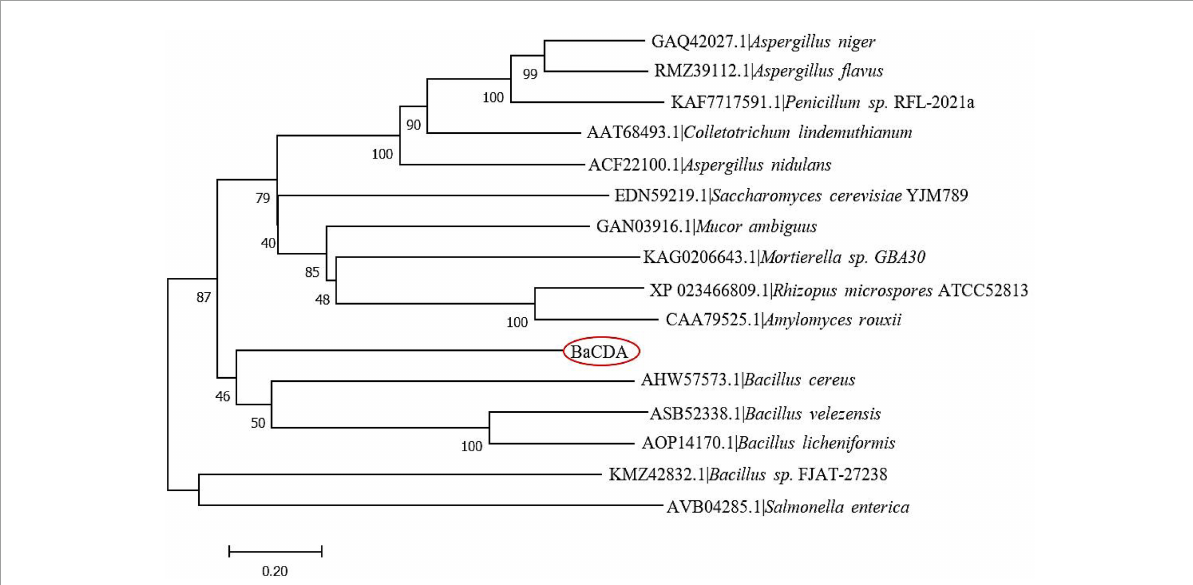
FIGURE9 Phylogenetic tree of B. aryabhattai TCI-16 CDA (BaCDA) with other CDA proteins from different microorganisms based on the amino acid sequence comparisons. The evolutionary history was inferred using the Neighbor-Joining method. The optimal tree with the sum of branch length = 9.99177349 is